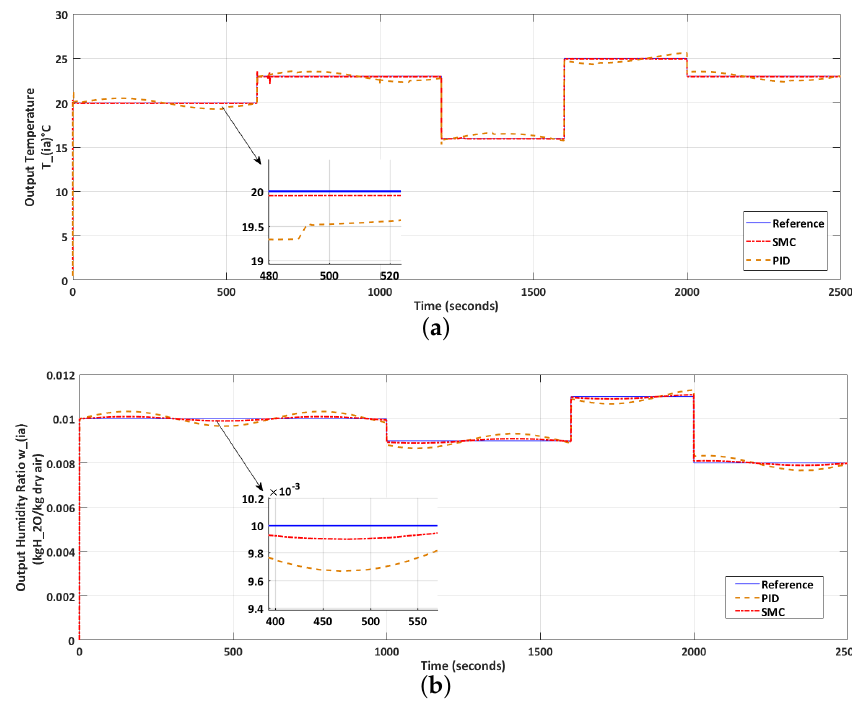
Figure 11. Output response of proportional-integral-derivative (PID) and sliding mode control (SMC) for multilevel steps input for ( a ) temperature and ( b ) humidity. The performance comparison for less frequent actuator